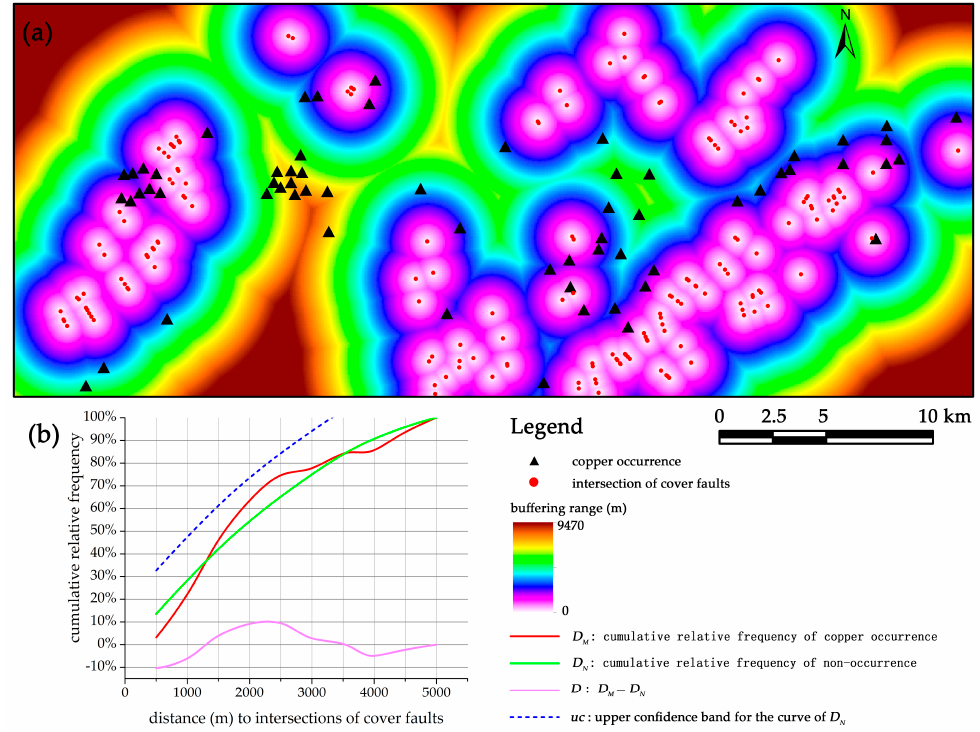
Figure 11. ( a ) Buffer analysis and ( b ) graph of cumulative relative frequency concerning distance to NW-trending faults.